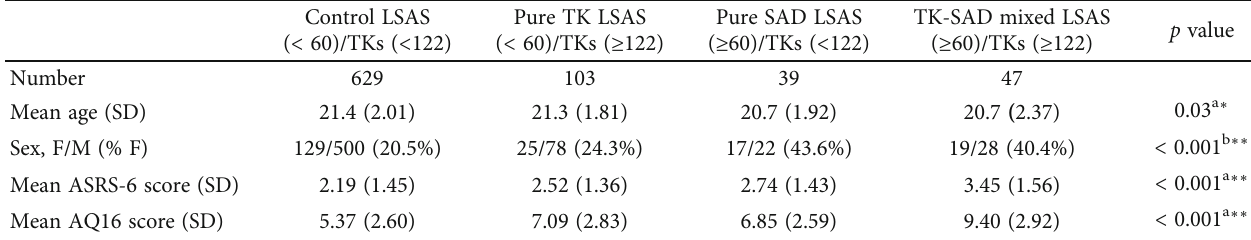
Table 3: Characteristics of participants classi fi ed according to TKs and LSAS cut-o ff values.